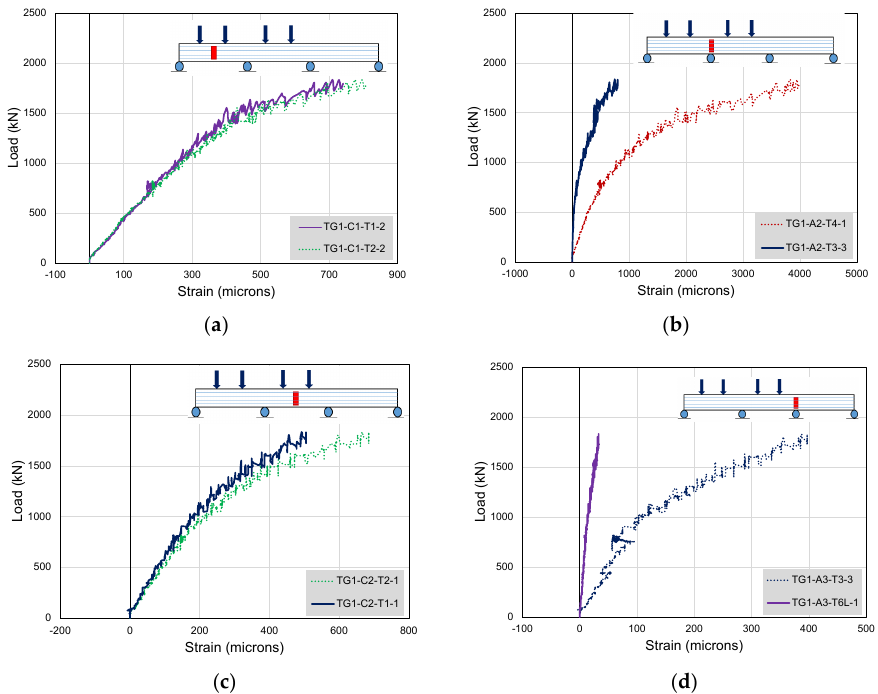
Figure 41. Tendon strains recorded during loading setup SP-1-L04 at locations ( a ) C1, ( b ) A2, ( c ) C2, and ( d ) A3.